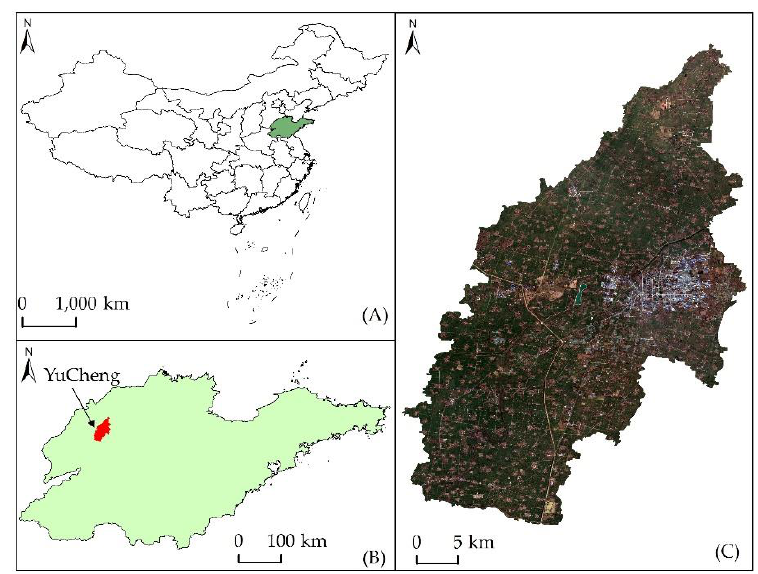
Figure 1. The location of Shandong Province in China ( A ); the location of the study area in Shandong Province ( B ); the study area is shown in one true color (R: red, G: green, B: blue) image using ZY-3 data of 2 December 2014 ( C ).